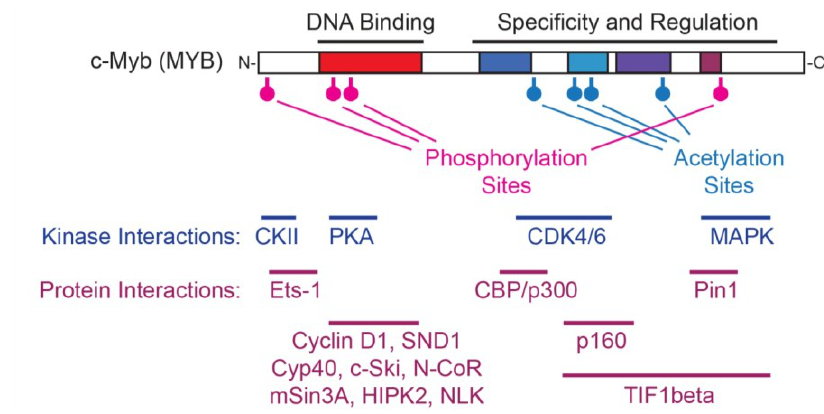
Figure 5. Multiple Regulatory Pathways Lead to Myb. The c-Myb protein is diagrammed at top, with DNA binding domain (red) and C-terminal regulatory domains labeled. Sites of phosphorylation and acetylation are indicated. The lower section shows the approximate binding or interaction sites for kinases or other proteins. Please see the legend to Figure 1 for an explanation of the conserved, shaded domains in the c-Myb